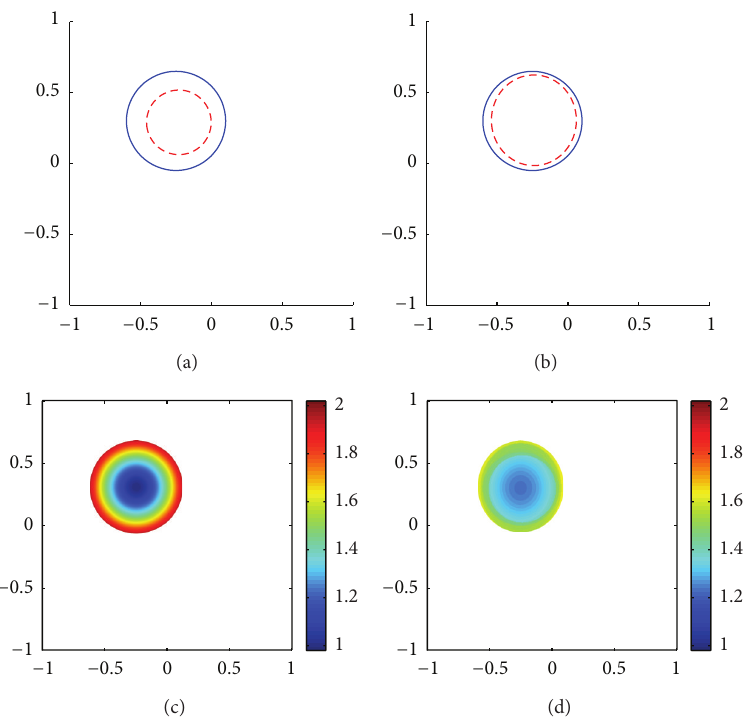
Figure 8: Reconstruction an object with space-dependent parameter 𝑘 𝑖 . (a) True object (blue solid line) and initial guess (red dashed line). (b) True object (blue solid line) and its final reconstruction (red dashed line) at the ninth iteration with respect to the domain. (c) True function 𝑘 𝑘 𝑖 . (d) Final reconstruction of 𝑖